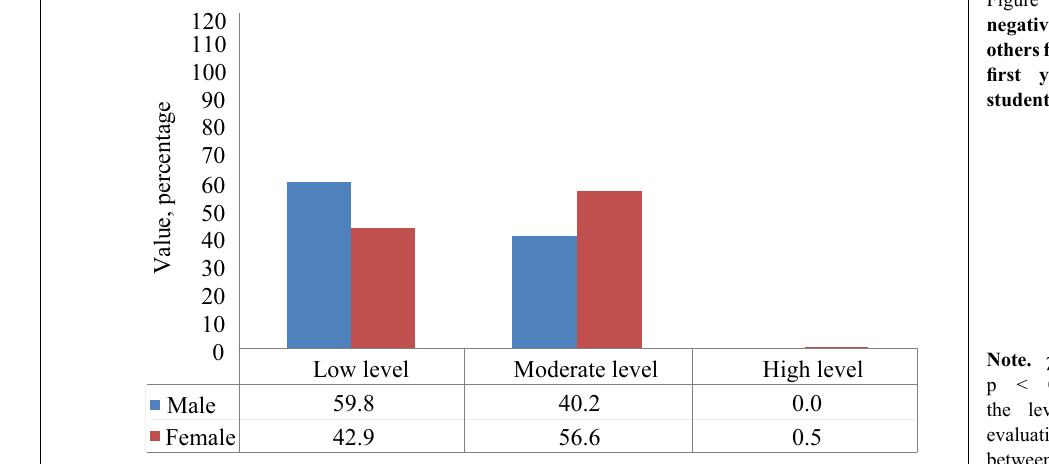
between girls and boys.